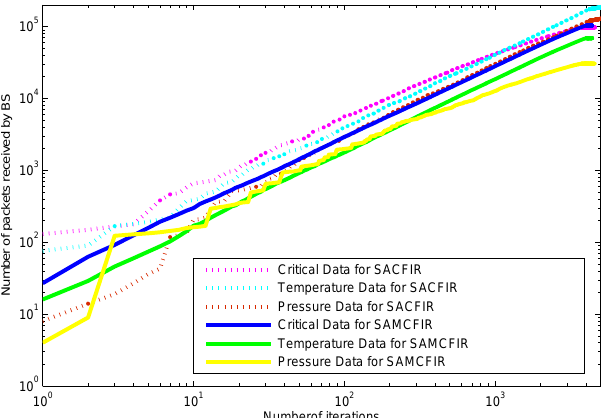
Figure 15. Multi-type data received at BS on network operation in network of 300 m × 300 m with 200 nodes.